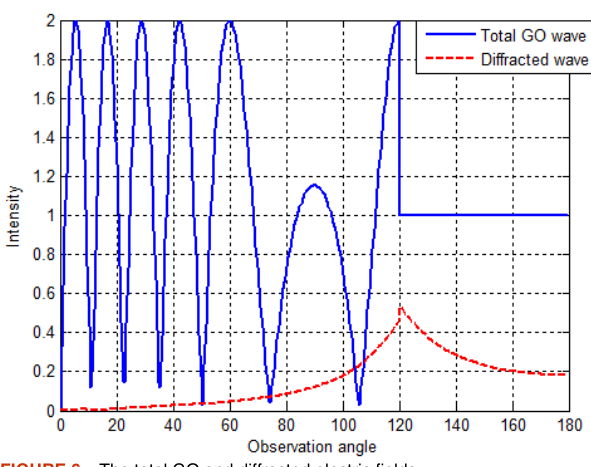
FIGURE 6. The total GO and diffracted electric fields.